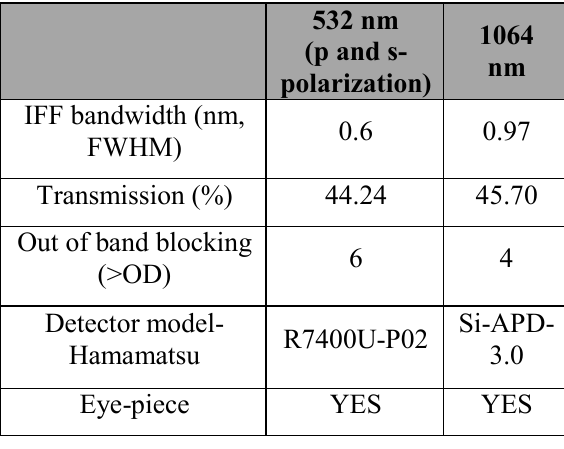
Table 2. Technical characteristics of the optical components of the wavelength separation system of